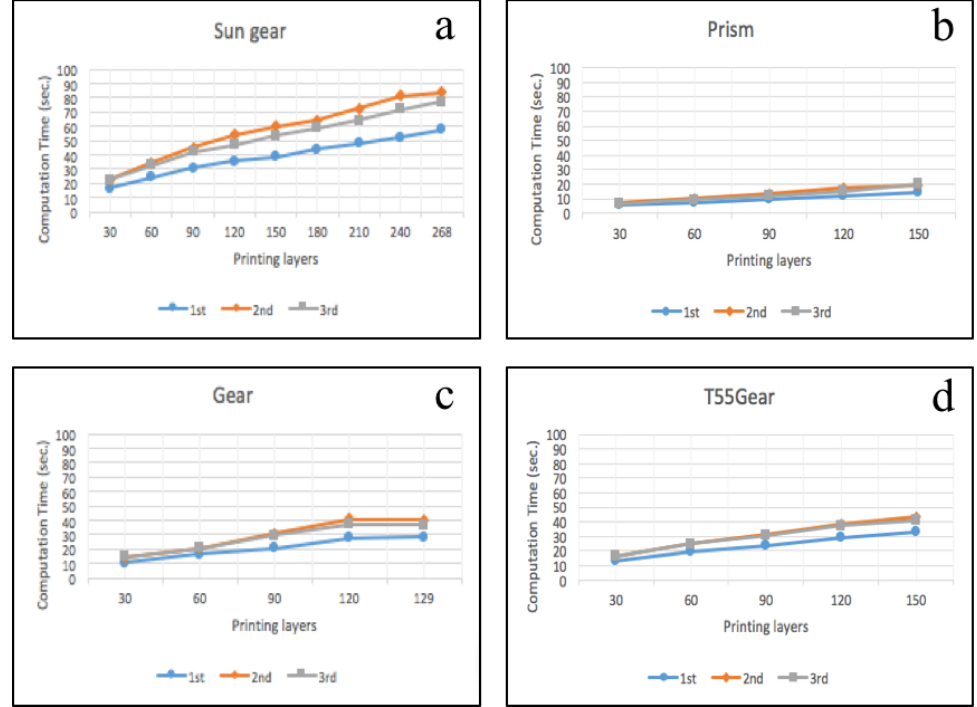
Figure 15. Image pre-processing—Non-rescale and rectification: the computation time of normal printing state for ( a ) sun gear; ( b ) prism; ( c ) gear; and ( d ) t55gear. Failure Printing State